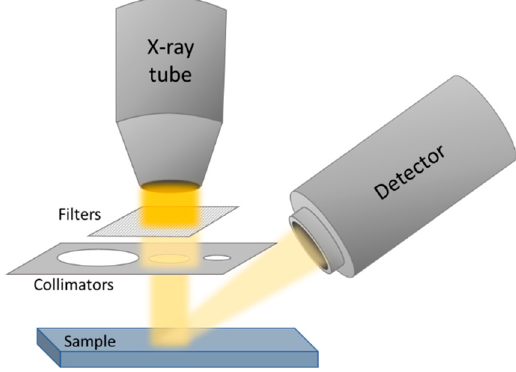
Figure 11. Scheme of the principal components of XRF.